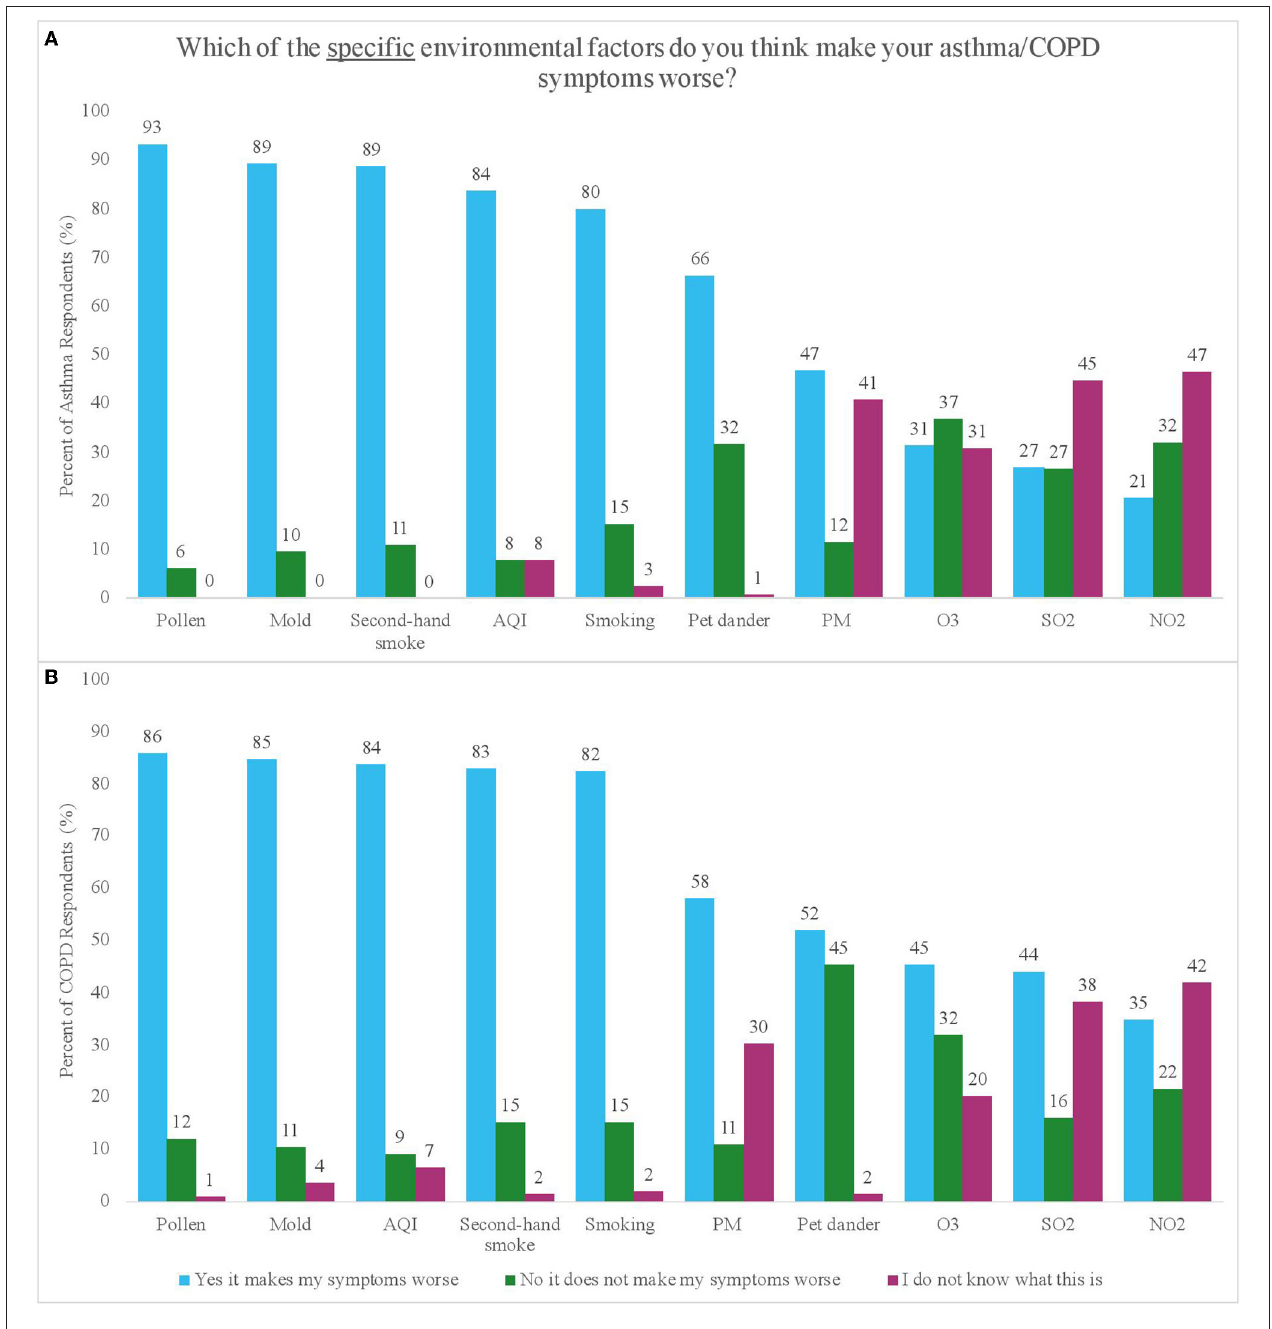
FIGURE 3 | (A,B) Percent of respondents with asthma (A) and COPD (B) who reported perceiving or not perceiving an impact of different environmental factors on their symptoms, as well as the percentage of respondents who reported not knowing what the factor